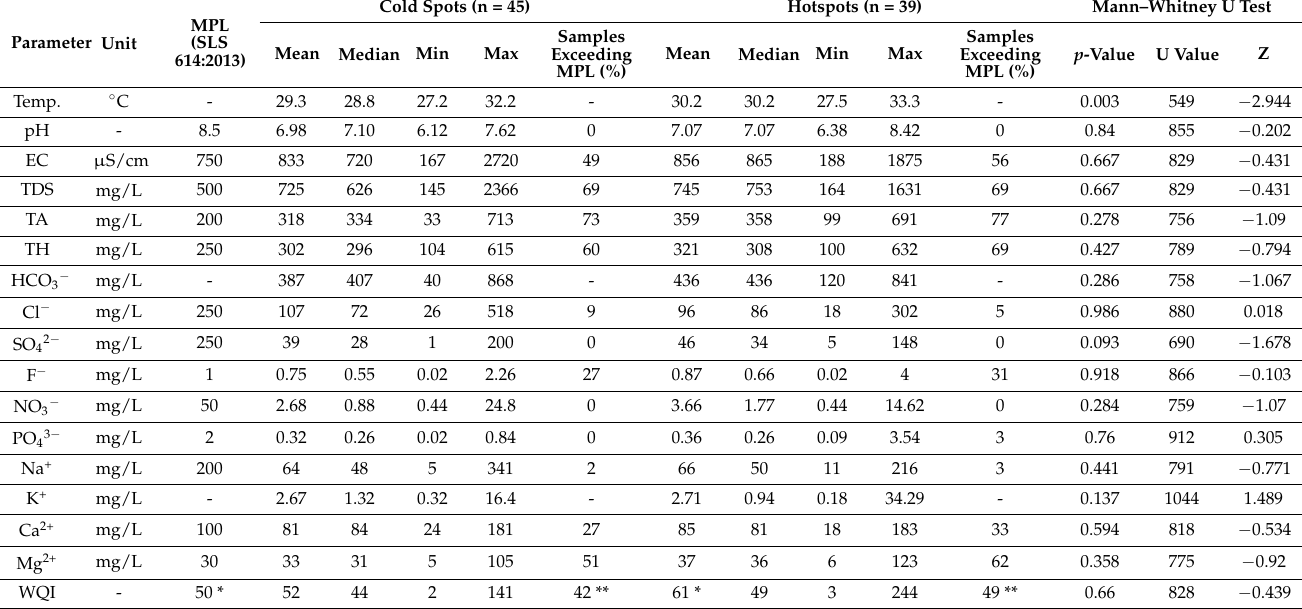
Table 2. Descriptive statistics of groundwater quality parameters in the Yan Oya river basin [EC— electrical conductivity; TDS—total dissolved solids; TA—total alkalinity; TH—total hardness; MPL— maximum permissible level recommended for drinking under the Sri Lanka standards for potable water (SLS 614: 2013)]. * WQI value for poor quality; ** % samples exceeding WQI value for poor quality; “-” indicates “not